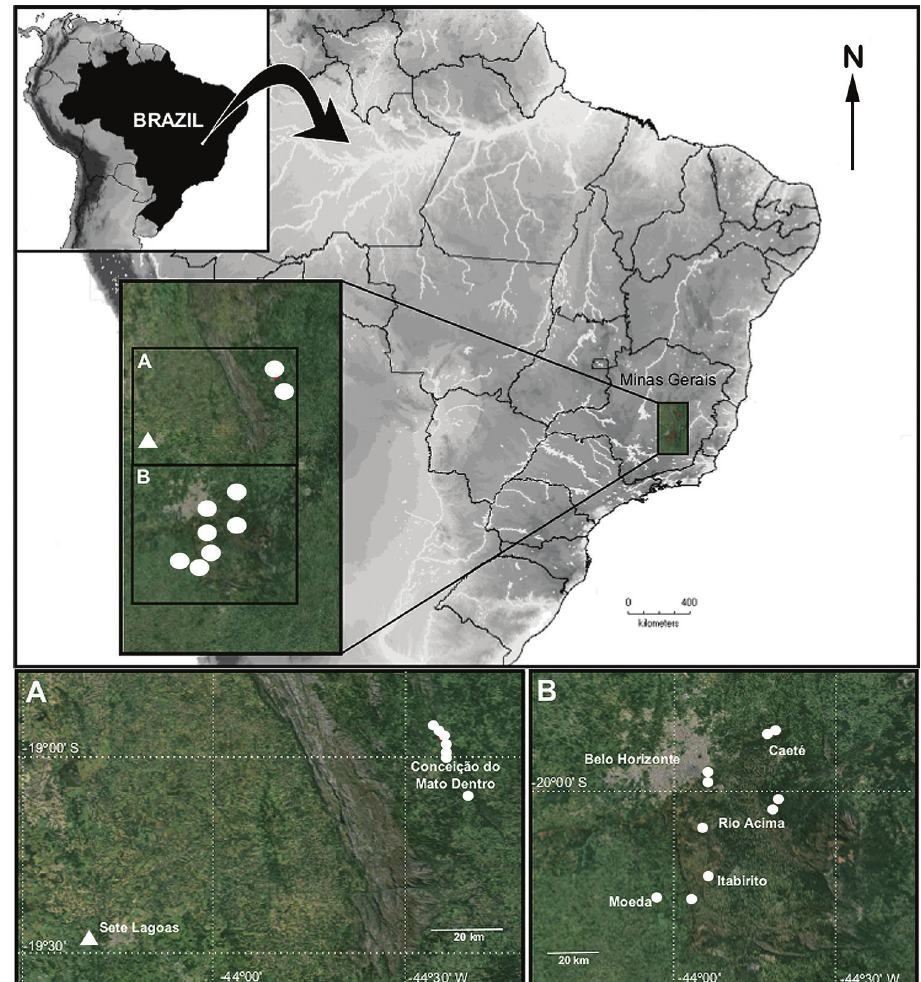
Figure 18. Distribution maps of Tisentnops mineiro sp. n (white circles) and Tisentnops onix sp. n. (white triangles) from the state of Minas Gerais,